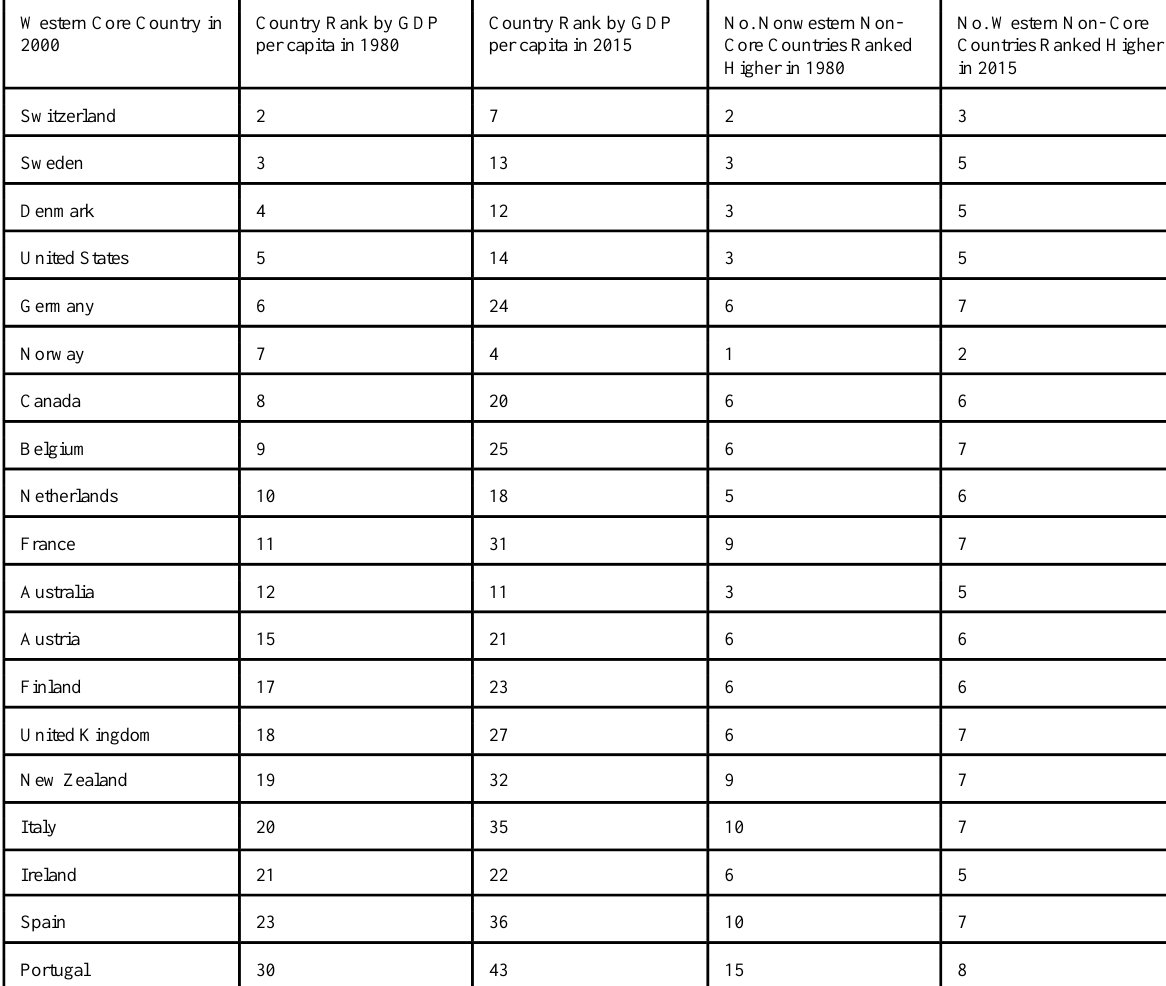
Table 4 . Semiperipheral Challenges to the Western Core between 1980 and